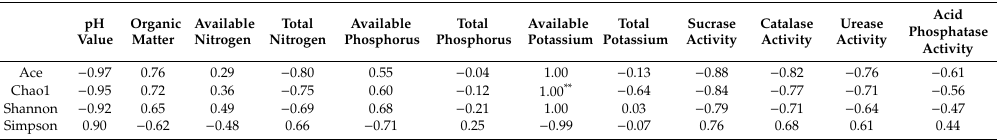
Table 4. Correlation analysis of diversity indices and soil properties. The correlation coe ffi cient and significance were obtained using Pearson correlation analysis. Significant values are shown as: ** p <